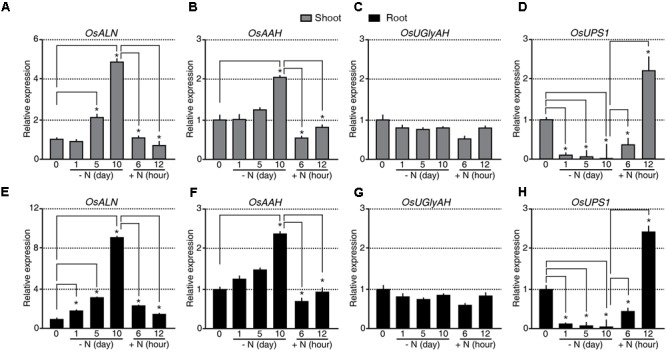
Expression of OsALN and OsUPS1 changes rapidly in response to changing N status. qRT-PCR analysis of OsALN expression in shoots (A–D) and roots (E–H) following N starvation and re-application treatments (A,E), OsAAH
(B,F), OsUGlyAH
(C,G), and OsUPS1
(D,H). OsUBI1 expression was used as an internal control. Data shown are the mean + SD of two biological and two technical replicates. Asterisks indicate significant differences based on a 95% confidence interval by a Student’s t-test.